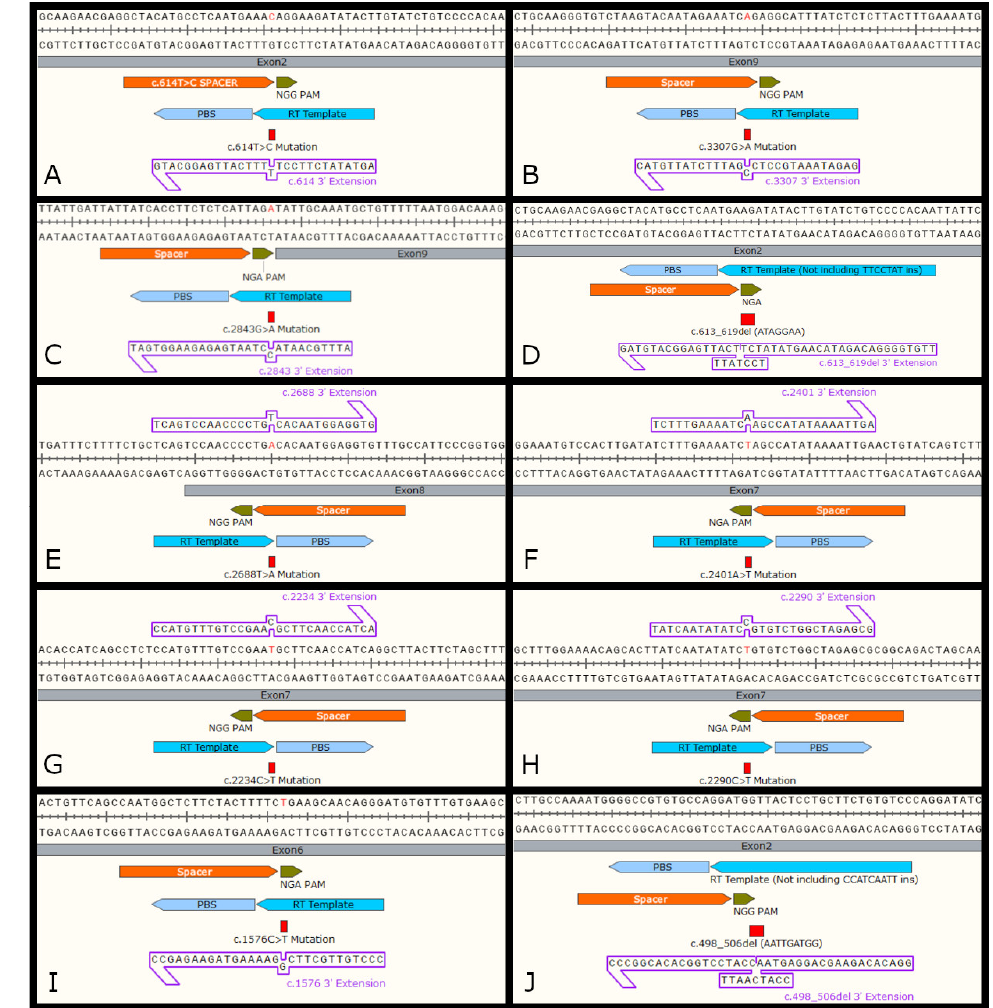
Figure 4. Prime editing design for the top 10 prevalent CRB1 mutations—c.614T>C ( A ), c.3307A>G ( B ), c.2843AG>A ( C ), c.613_619del (ATAGGAA)( D ), c.2688T>A ( E ), c.2401A>T ( F ), c.2234C>T ( G ), c.2290C>T ( H ), c.1576C>T ( I ), and c.498_506del (AATTGATGG)( J ).